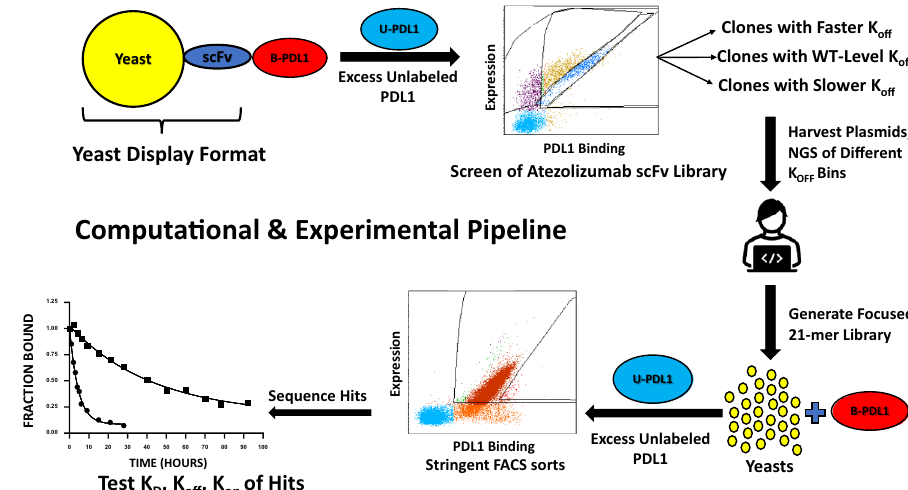
Fig. 1 | Computationaland experimentalpipeline. Schematicillustration of the RESPcomputationaland experimentalpipeline,U-PD-L1and B-PD-L1are unlabeled and biotin-labeled PD-L1,